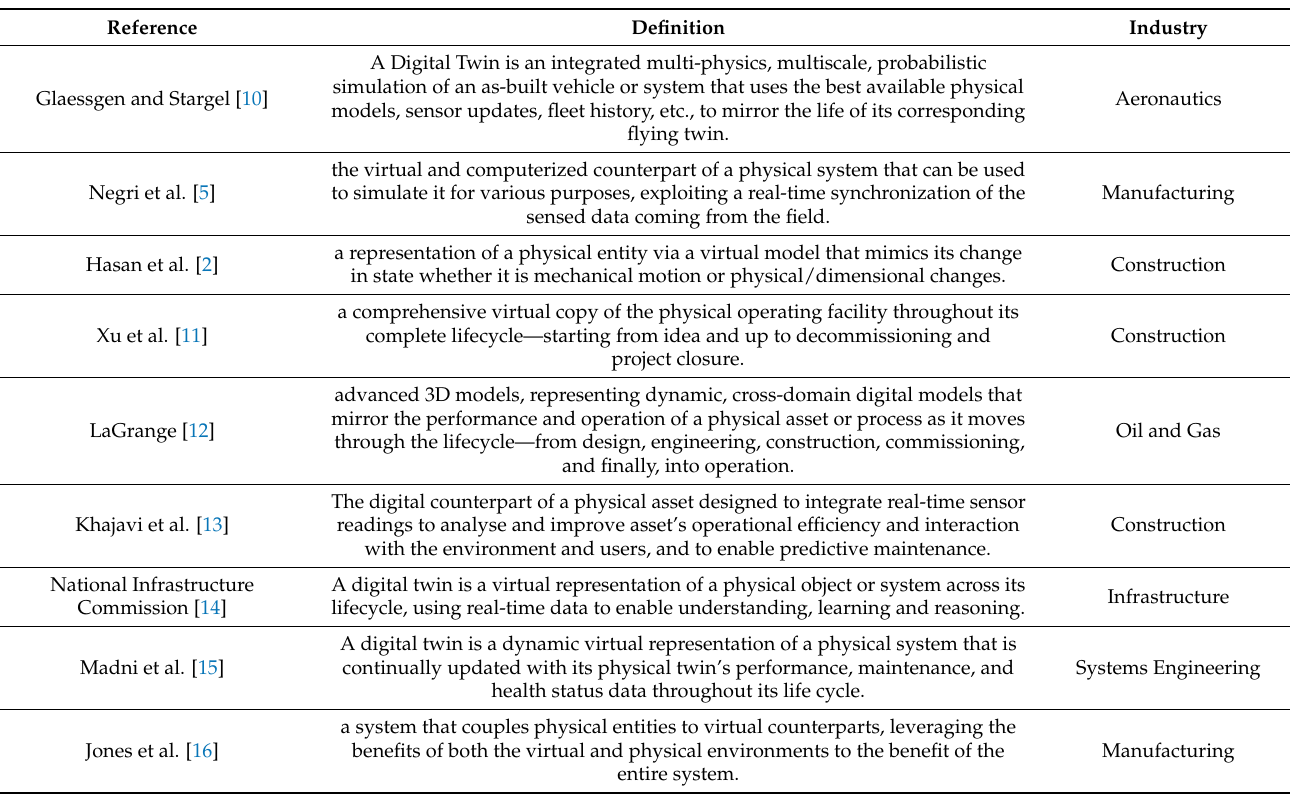
Table 1. Definitions of Digital Twin in various